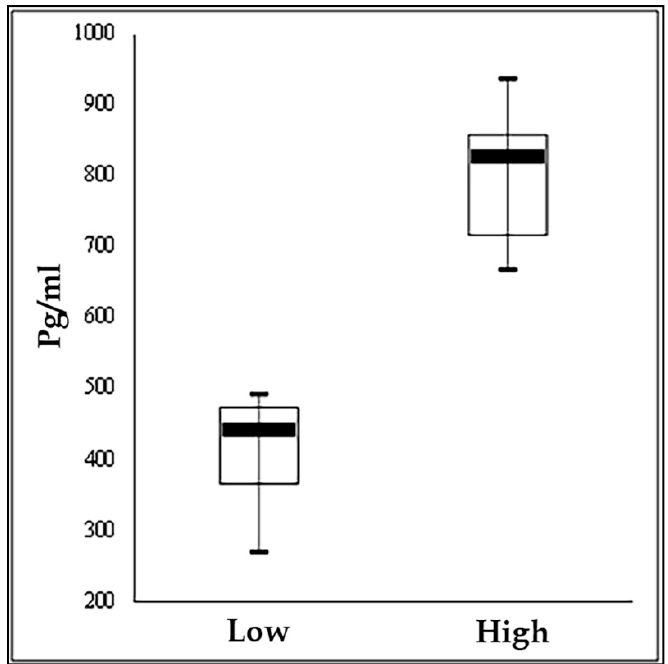
Figure 1. Box plot of milk cortisol distribution of 10 cows with the higher and the 10 cows with the lower values. Table 1. Body condition score (BCS), parity, days in milking (DIM) and milk yield and quality in the 10 cows with lowest and 10 cows with highest cortisol concentration in milk.